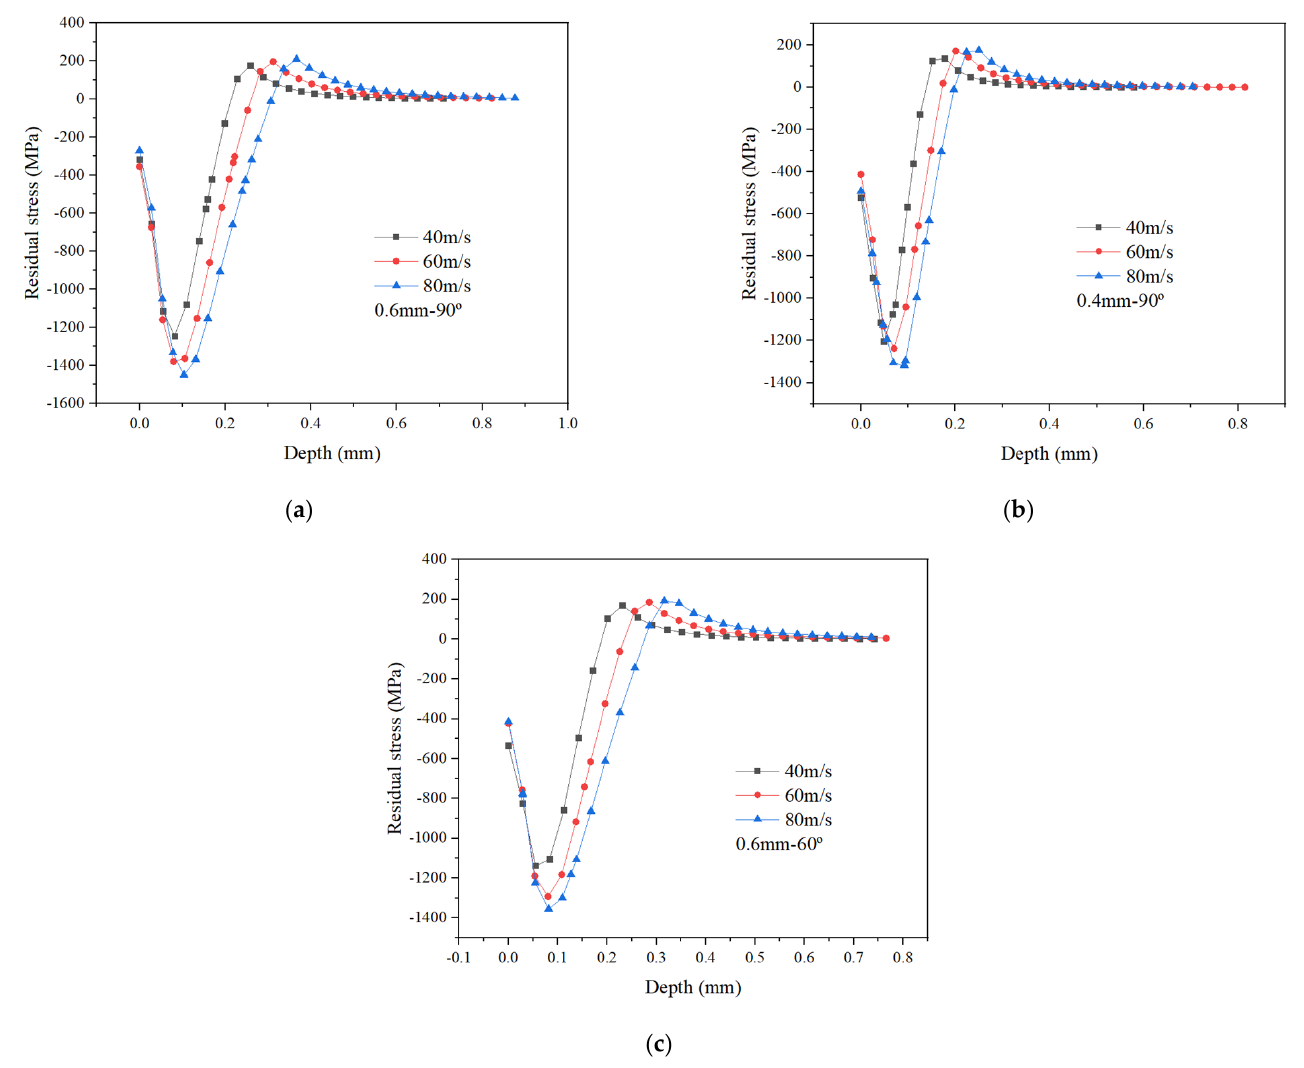
Figure 4. Effect of ball impact velocity on residual stress under different processing parameters. ( a ) d p = 0.6 mm and α p = 90°; ( b ) d p = 0.4 mm and α p = 90°; ( c ) d p = 0.6 mm and α p = 60°.